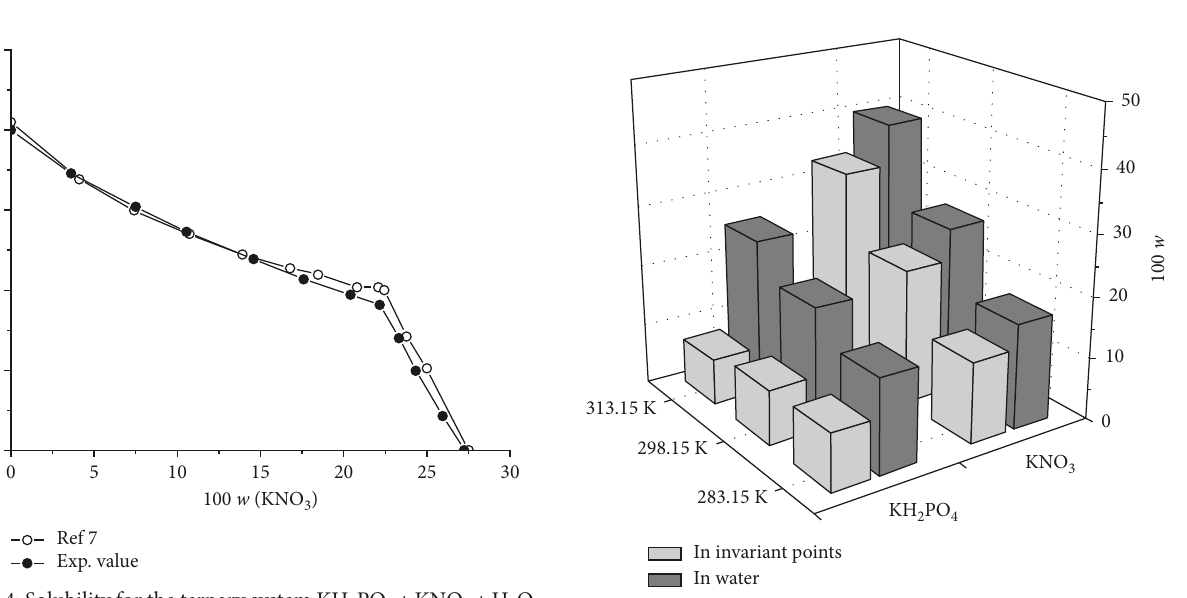
2 PO 4 and KNO 3 solubility in